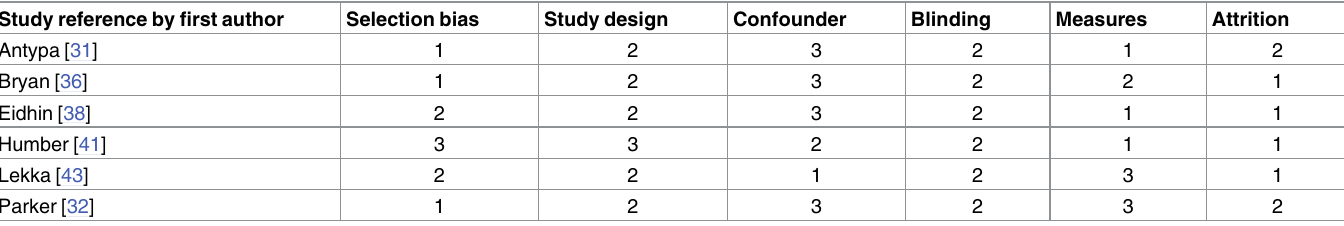
Table 3. Quality ratings based on the EPHPP protocol.